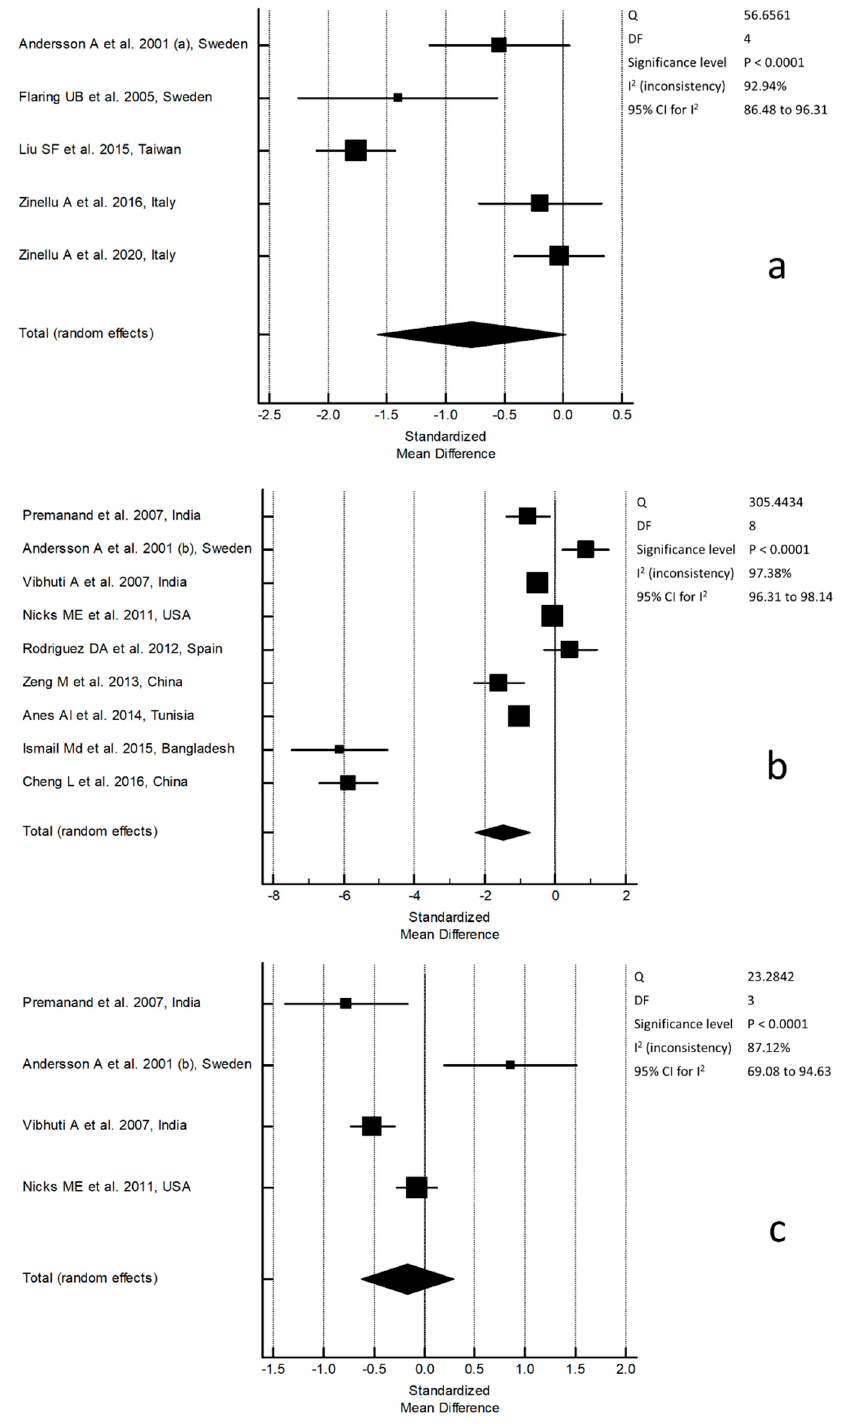
Figure 2. Forest plot of studies examining ( a ) serum/plasma total glutathione (tGSH) concentra- tions, ( b ) serum/plasma reduced glutathione (rGSH) concentrations, and ( c ) serum/plasma rGSH concentrations depending on whether rGSH fall into a cutoff for control groups of 0.5–5.0 µmol/L.